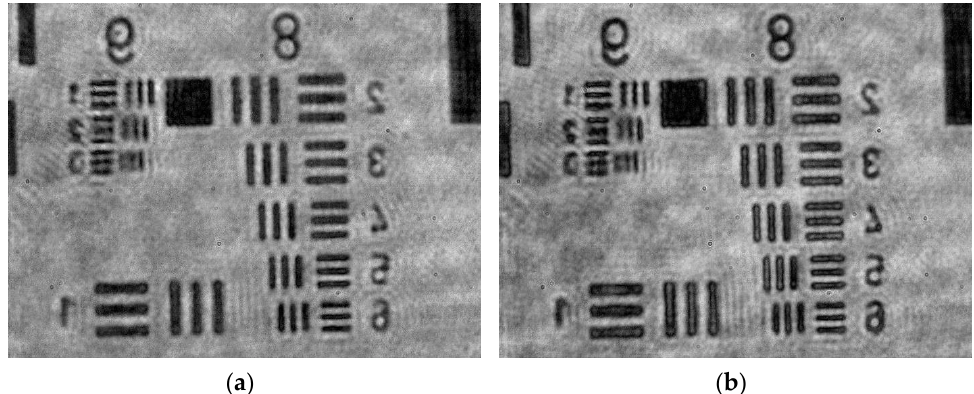
Figure 5. High-resolution test target: reconstructed image of the ( a ) bright field and ( b ) dark field using IDFDHM